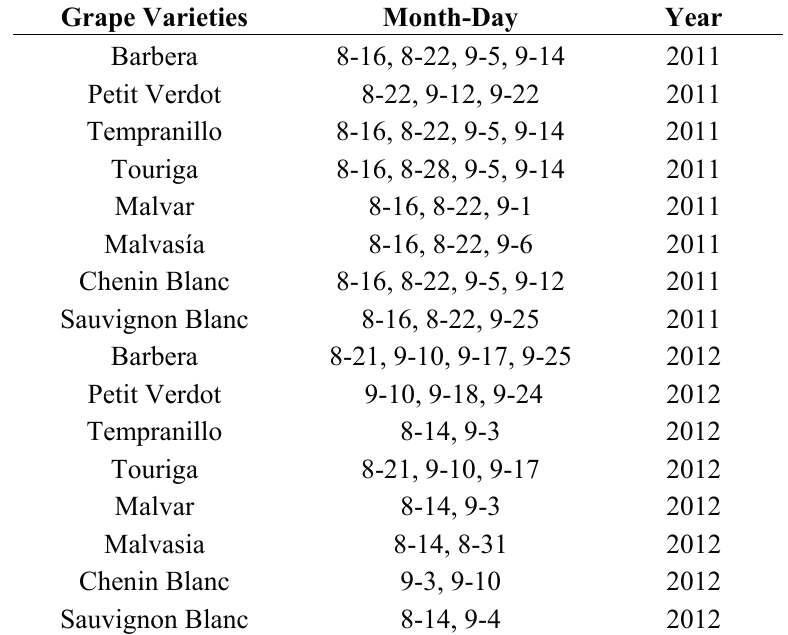
Table 2. Grape collection date of the different varieties used for the electronic nose